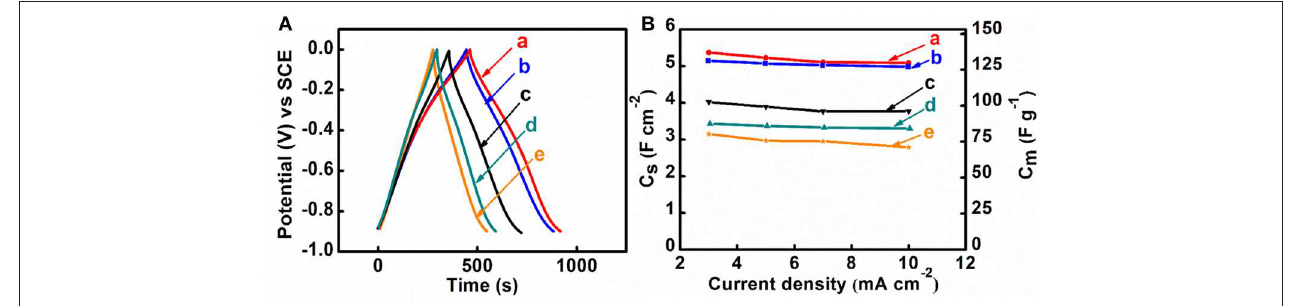
FIGURE 7 | (A) Charge-discharge curves at current density of 5mA cm − 2 , (B) capacitance, calculated from charge-discharge data, vs. current density for (a) M-CB-MWCNT, (b) M-FH-CB-MWCNT, (c) M-PV-MWCNT, (d) M-AA-MWCNT and (e) M-CP-MWCNT.